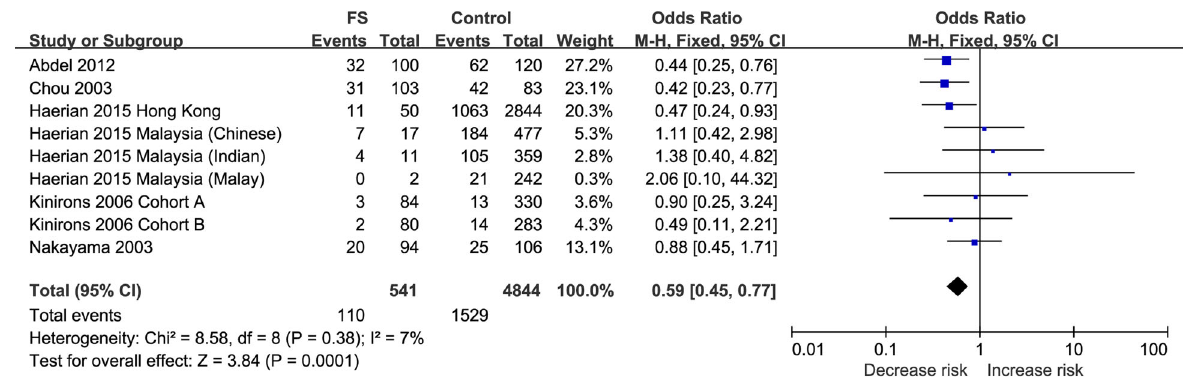
Fig. 4 Forest plot of subgroup analysis in healthy controls. The GABRG2 rs211037 polymorphism was significantly related to the risk of FS in healthy controls